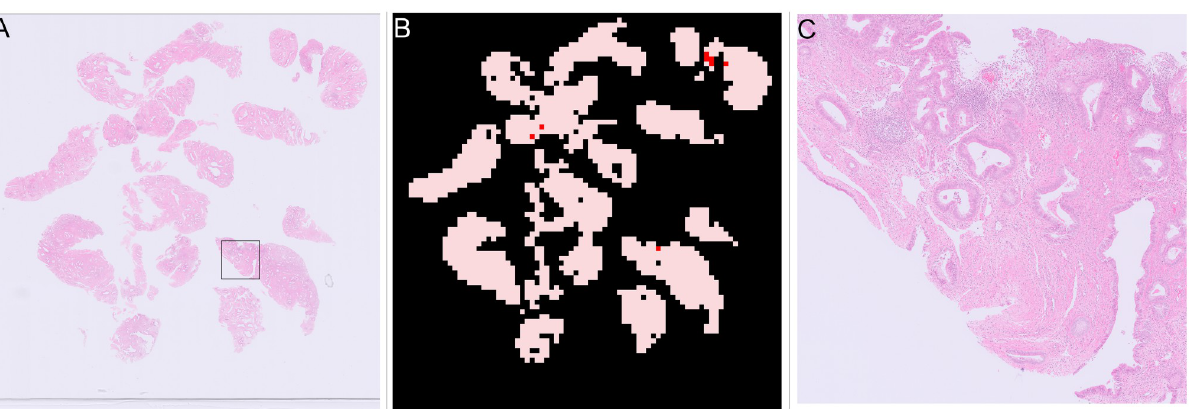
Fig 15. Example of error in blood and mucus detection. (A) Thumbnail of slide with blood and mucus detection problem, square shows location of region in Fig 15c. (B) Mask, areas in pink patches detected as “blood or mucus”, areas in red are tissue. (C) Zoomed in view of area that should be “blood or mucus”, clearly showing